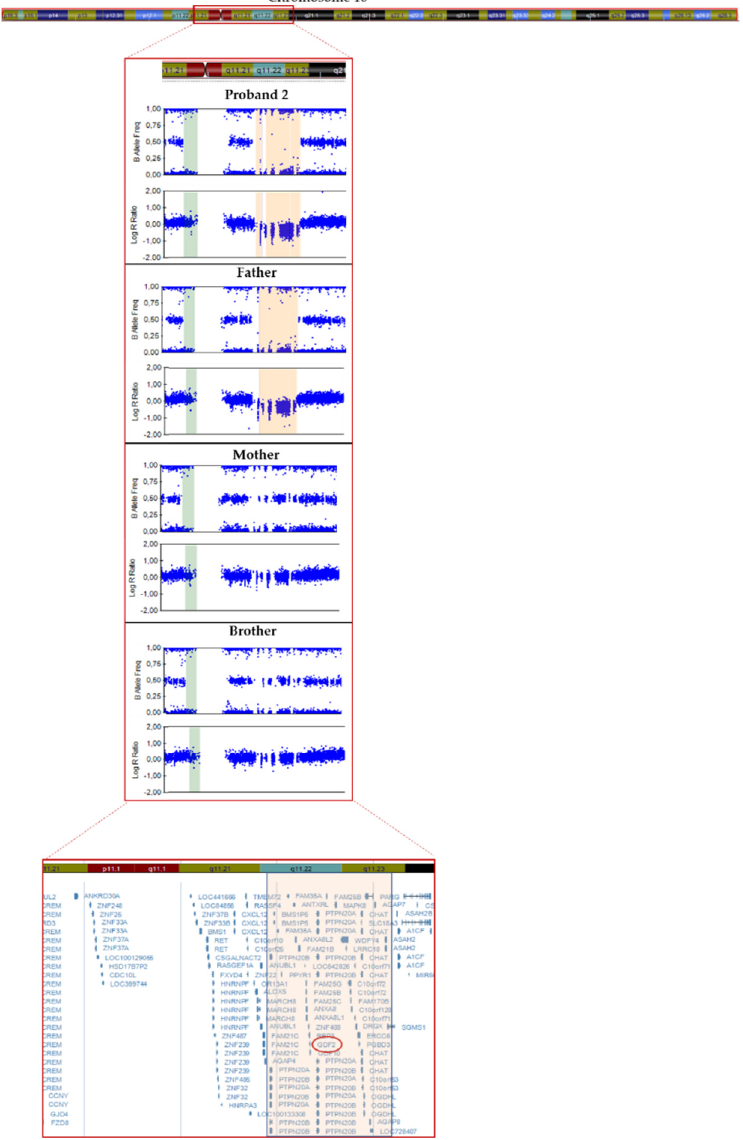
Figure 3. Resolution of the SNP array carried out in proband 2 and family members showing